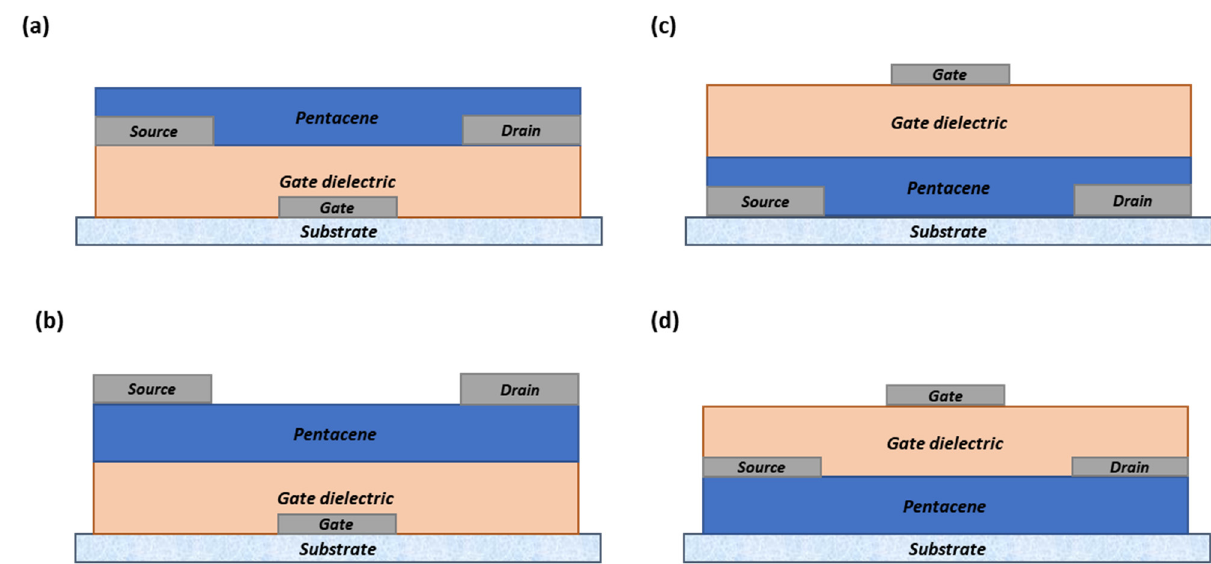
Figure 9. The common OTFT schematic structures: ( a ) bottom gate, bottom contact; ( b ) bottom gate, top contact; ( c ) top gate, bottom contact; ( d ) top gate, top contact.